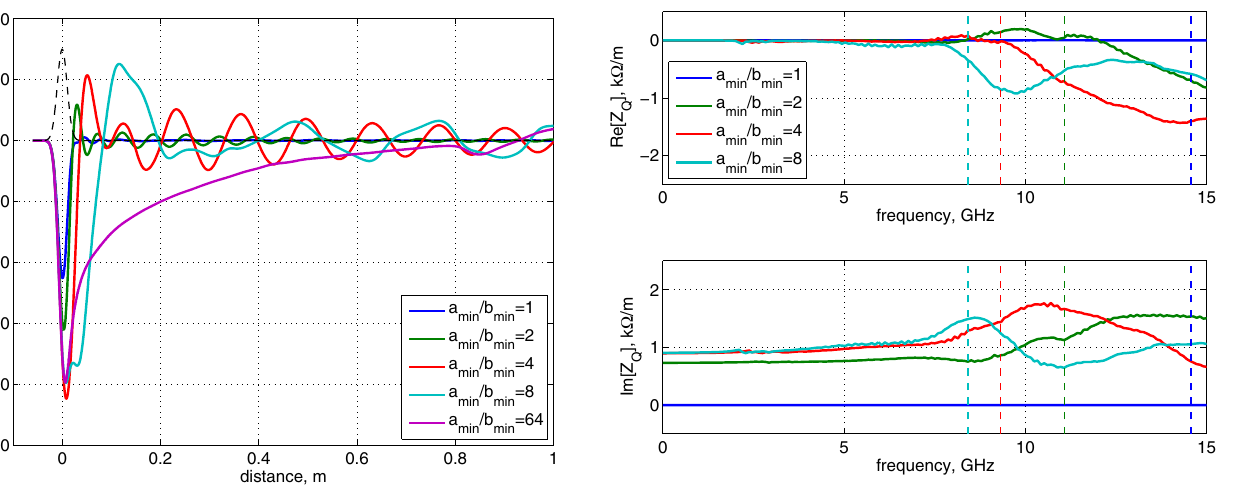
FIG. 4. (Color) Dipolar vertical wake potentials (solid line) and beam density (dashed